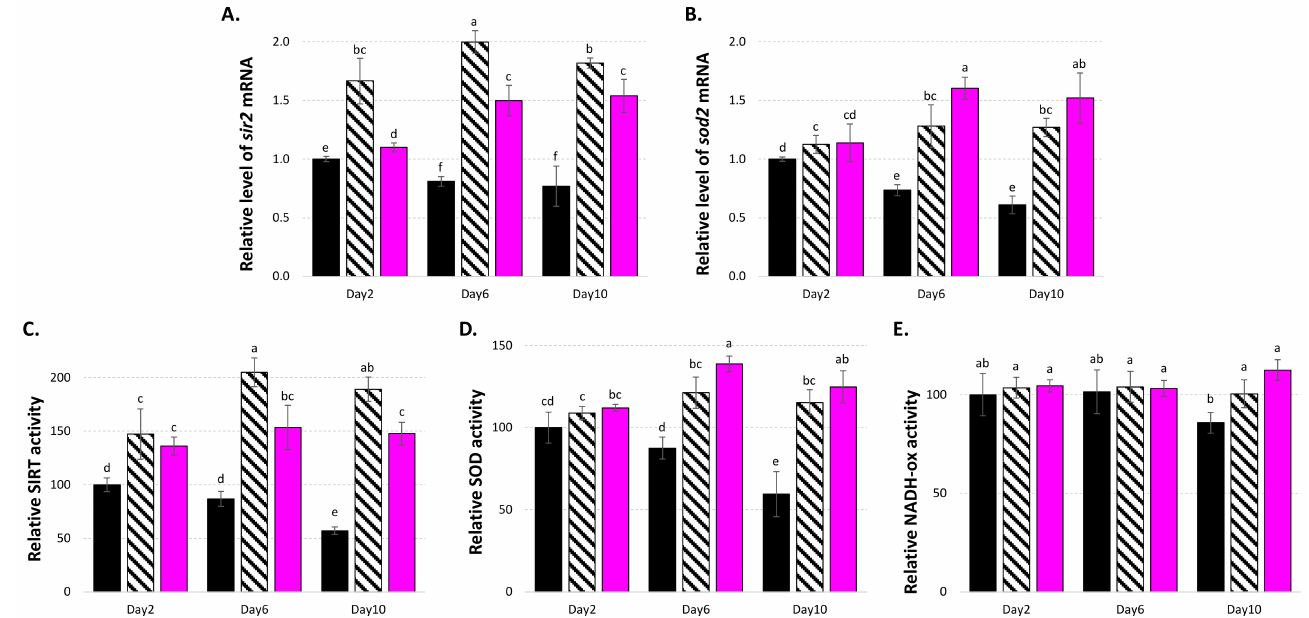
Figure 6. Effects of LSE on: ( A ) sir2 and ( B ) sod2 gene expression; ( C ) SIRT1; ( D ) SOD; and ( E ) NADH oxidase enzyme activities. LSE: sacred lotus stamen extract (0.5 mg/mL); RES: E-resveratrol (10 µ M) used as positive antiaging control. Significant differences ( p < 0.05) are shown by different